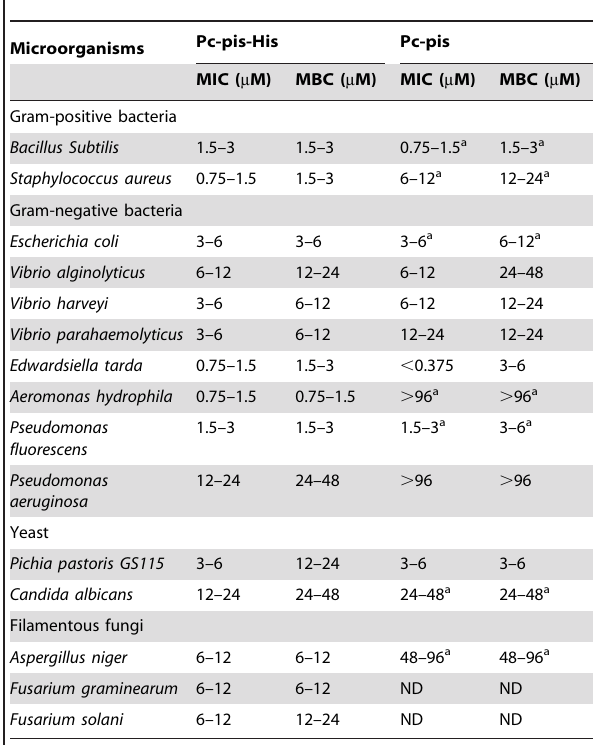
Table 1. Antimicrobial activity of Pc-pis-His and